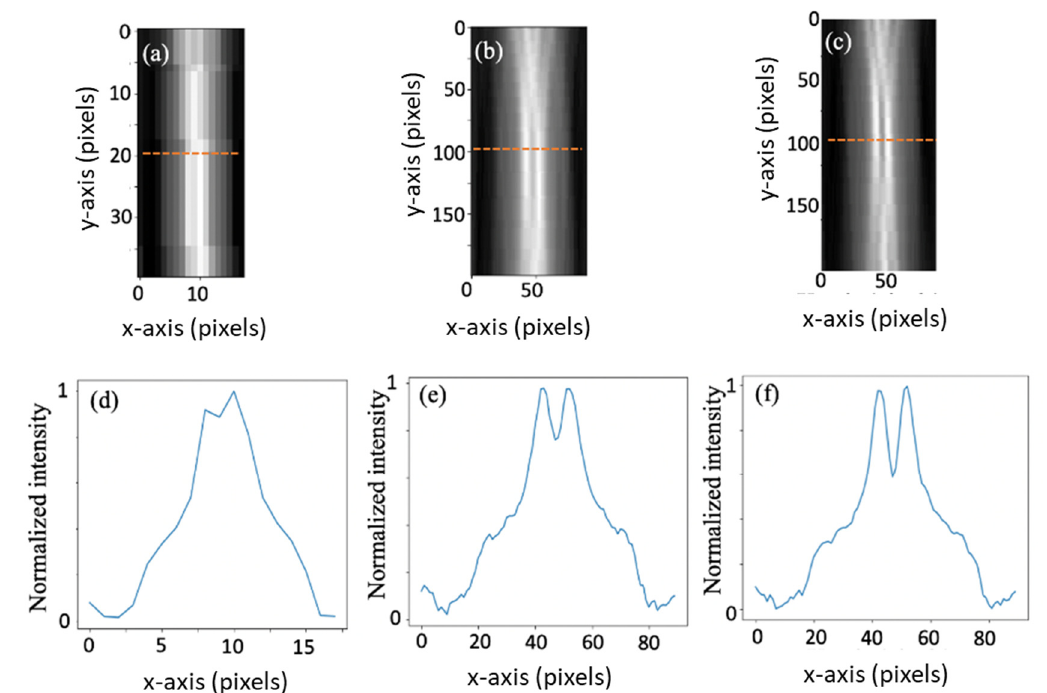
Figure 5. A single view reconstruction. ( a , b , c ) are reconstructions of a slice from a single view where ( a ) is a low-resolution image, ( b ) is a high-resolution image using our super-resolution concept, and ( c ) a high-resolution reference image. ( d , e ) and ( f ) are intensity profiles of the cross-sections marked with red lines in ( a , b ) and ( c ), respectively.